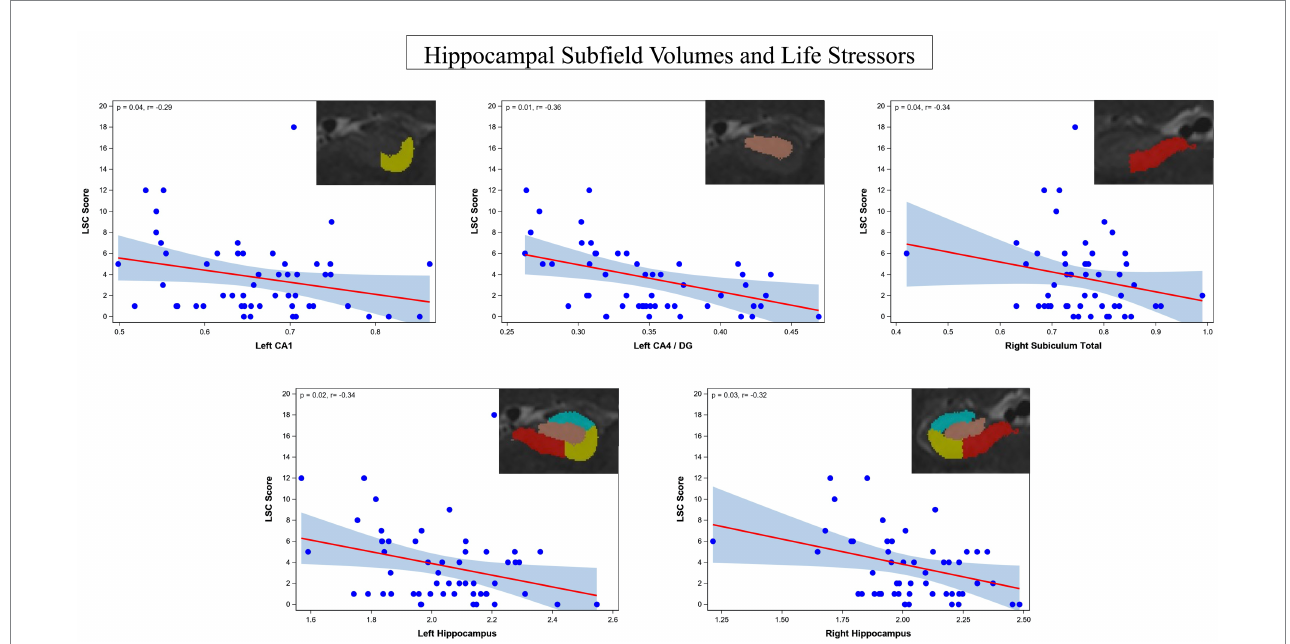
TABLE 4 Regression analysis findings for LSC score and hippocampal subfield volumes in MDD patients and healthy controls. Left hemisphere Right hemisphere Hippocampal subfield Raw / Adj p Cohen’s f 2 Raw / Adj p Cohen’s f 2 CA1 0.04 * /0.04 * 0.419 0.13/0.13 0.271 CA2/3 0.08/0.08 0.389 0.18/0.18 0.281 CA4/DG 0.01 * /0.02 * 0.584 0.14/0.14 0.696 Subiculum total 0.23/0.23 0.423 Hippocampus total 0.02 * /0.02 *